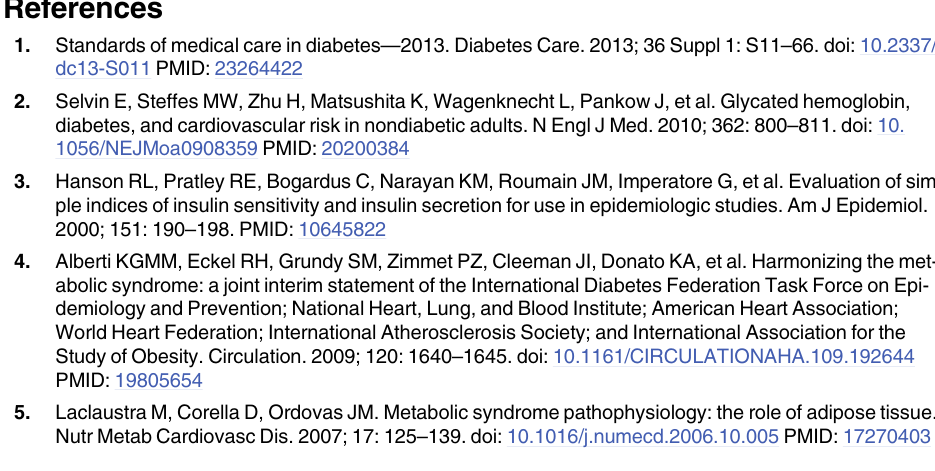
S1 File. Table A. Association of HbA1c and insulin groups with metabolic traits among partici- pants with metabolic syndrome. Table B. Association of HbA1c and insulin groups with meta- bolic traits among participants without metabolic syndrome. Table C. Association of HbA1c, insulin, glucose, and HOMA-IR tertiles with metabolic syndrome